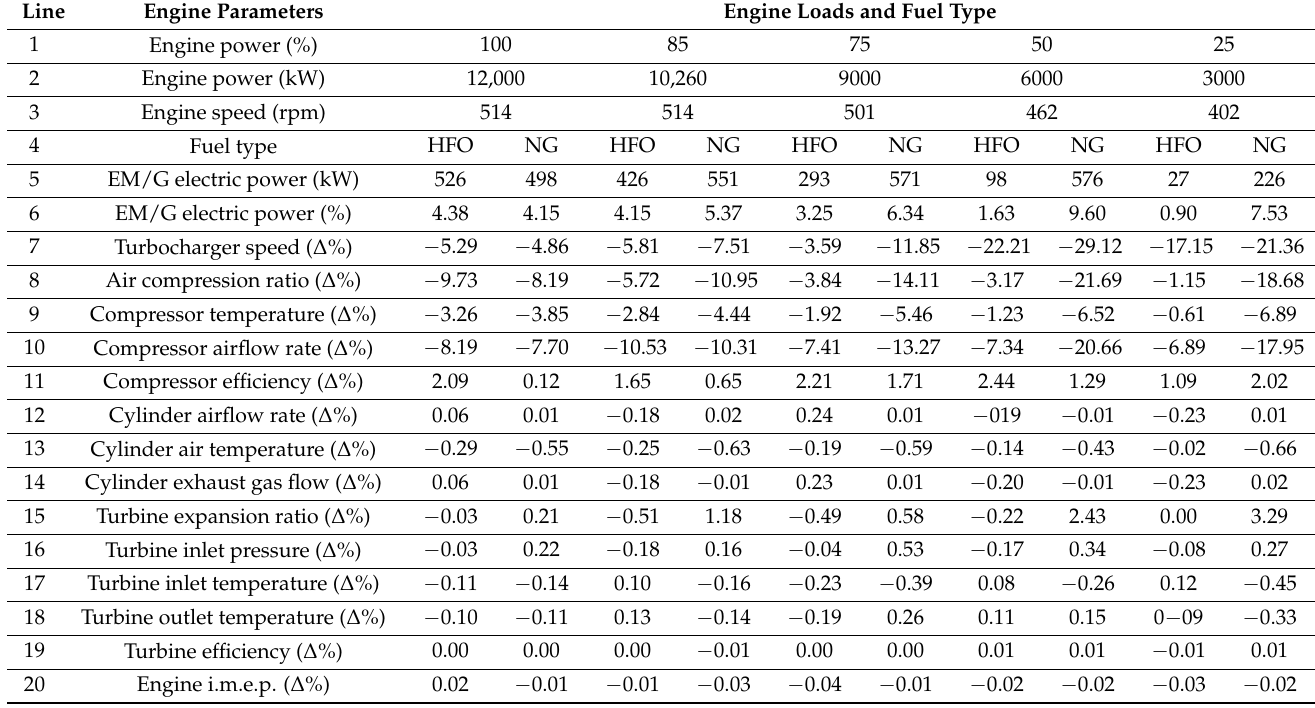
Table 4. TC and HTC comparison for different fuels and engine working points at variable